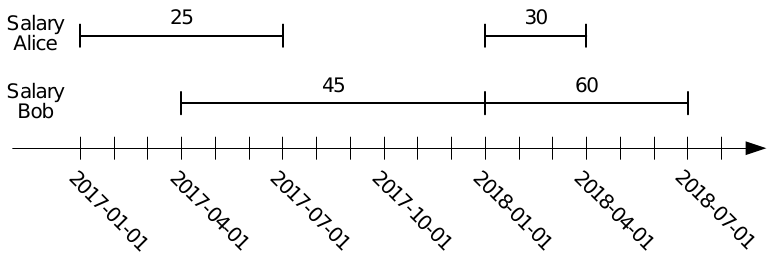
Figure 1. Representation of the evolution of salaries of two employees using the type temporal(integer)